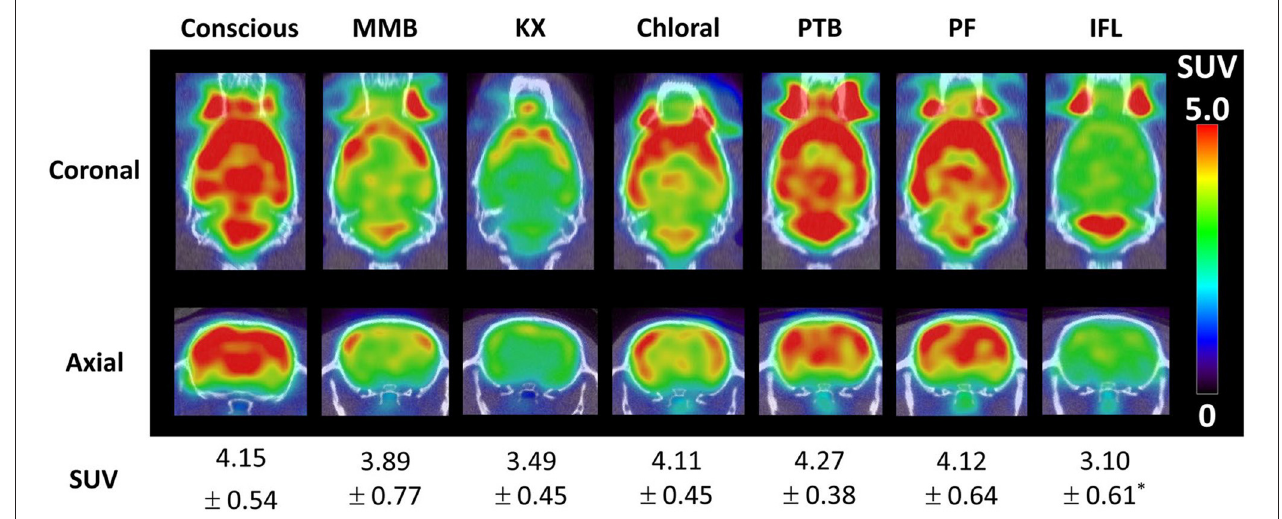
FIGURE 1 | Brain [ 18 F]FDG uptake in a conscious rat (using soft restrainer) and under different anesthetics (30). SUV, standardized uptake value. again and did not show difference compared to unrestrained